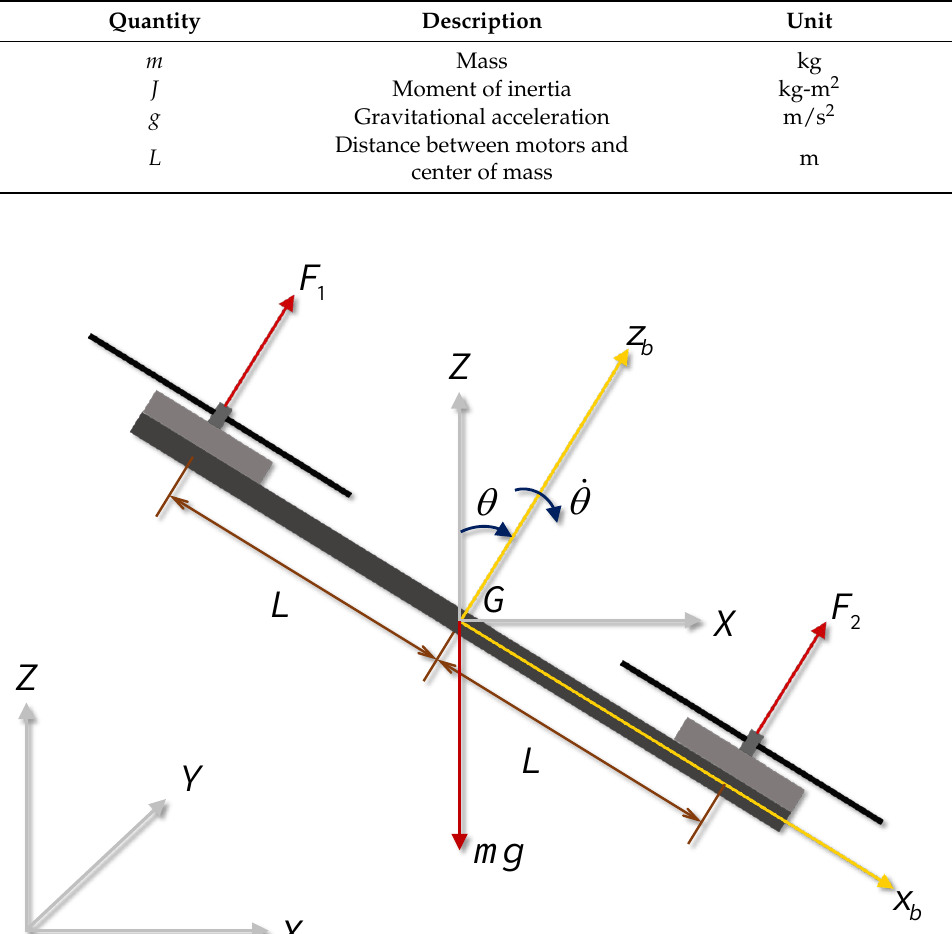
Table 1. Explanation of the physical quantities of the quadrotor planar motion system.